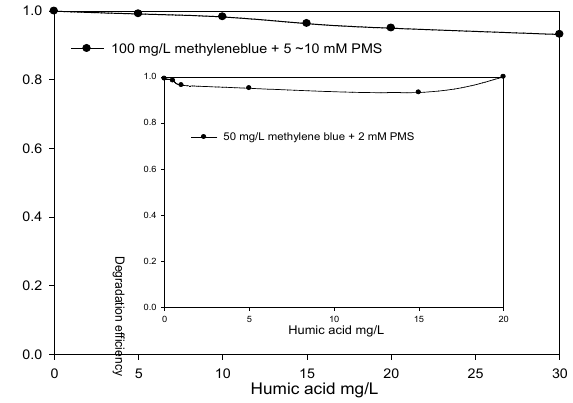
Figure 5: The effect of humic acid on the degradation of 50 mg/L and 100 mg/L methylene blue at high concentration of PMS (the mole ratio >12.8) for 24